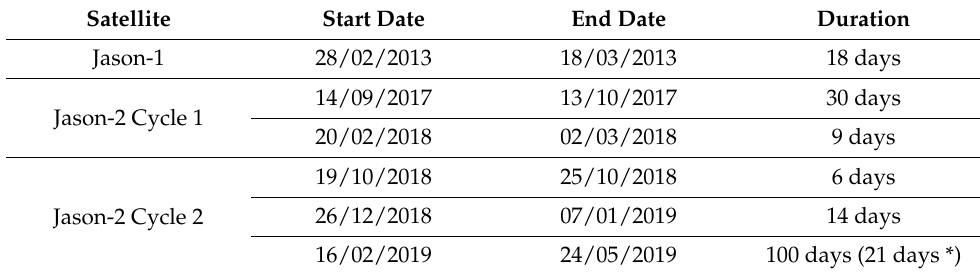
Table 2. Safe-holds for Jason-1 and Jason-2 during the two LRO cycles. Courtesy of Christoph Marechal, CNES. * See explanation in the text on mission “rewind” maneuver to remedy the